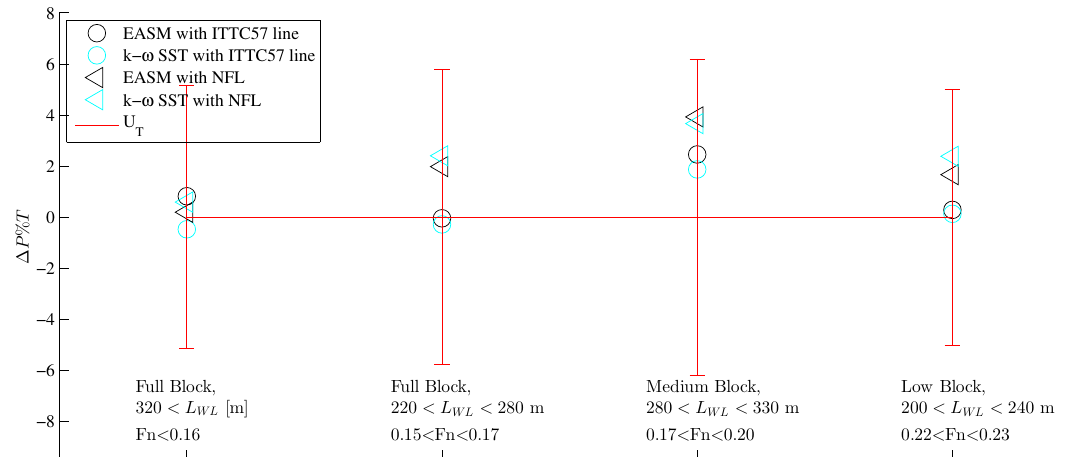
Figure 17. Relative change of the accuracy of the predictions, ∆ P % T = 0, made with the CFD based form factors compared to the predictions with the standard ITTC-78 method, based on 18 test cases and 78